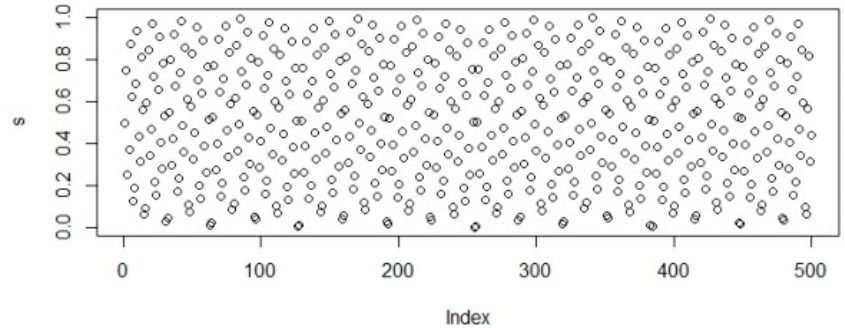
Figure 2. Population initialization using Sobol distribution .